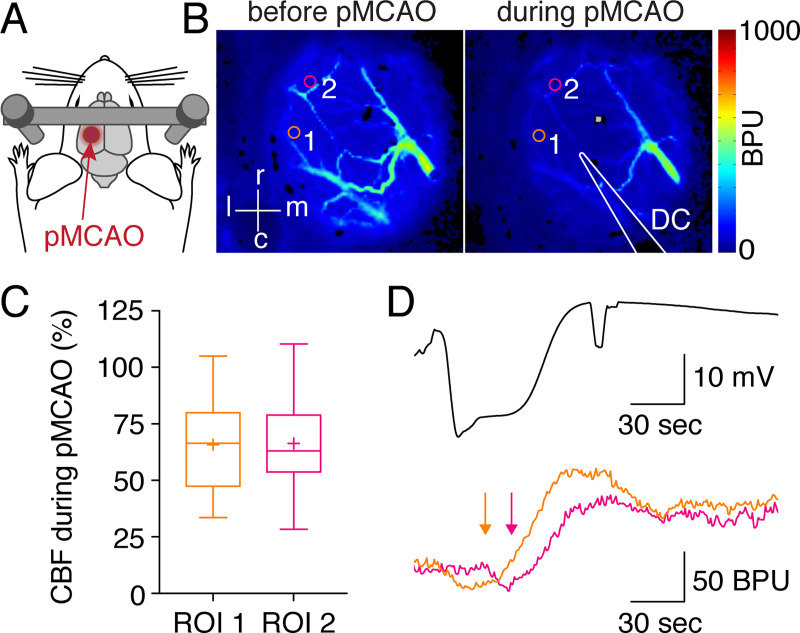
Measuring SDs in a rat model of focal stroke.(A-B) Permanent middle cerebral artery occlusion (pMCAO) was induced in rats, and relative changes in cerebral blood flow (CBF) in peri-infarct cortex were measured through a cortical window using laser speckle contrast imaging (BPU, blood perfusion units; l, lateral; m, medial; r, rostral; c, caudal). Regions of interest (ROI) are depicted by circles. An intracortical electrode was inserted for direct current (DC) potential measurement. (C) CBF relative to baseline decreased in both ROIs following pMCAO induction (n = 32 animals), indicating that experiments were carried out in peri-infarct cortex. (D) Representative examples of an SD after MCAO. A transient negative deflection of the DC potential, measured using an intracortical electrode, is accompanied by propagating transient CBF changes (arrows show the delay of onset indicating propagation).